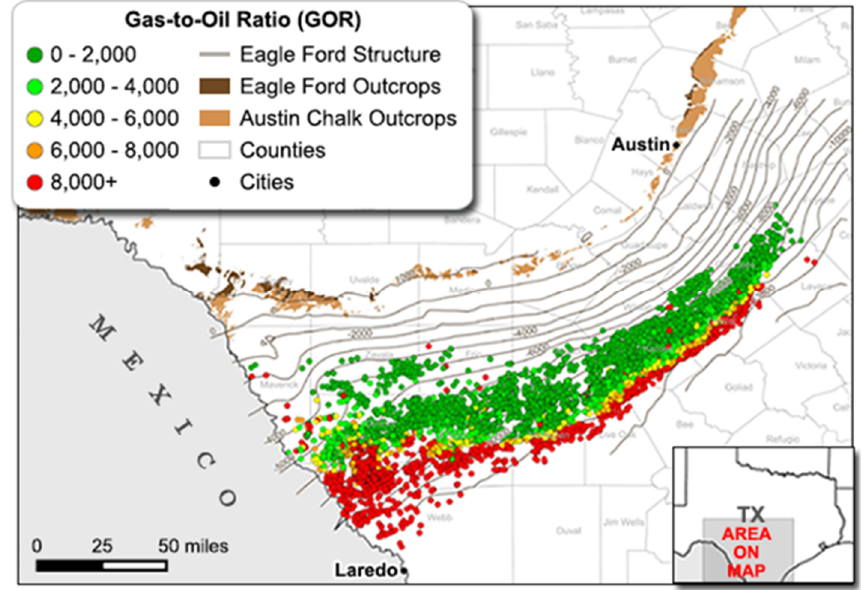
Figure 3. Initial gas-to-oil ratios (GORs) of Eagle Ford wells. Source: U.S. Energy Information Administration [24].